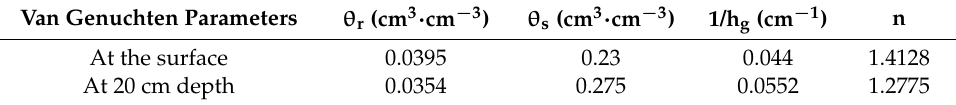
Table A2. van Genuchten-Mualem input parameters for HYDRUS 1D.